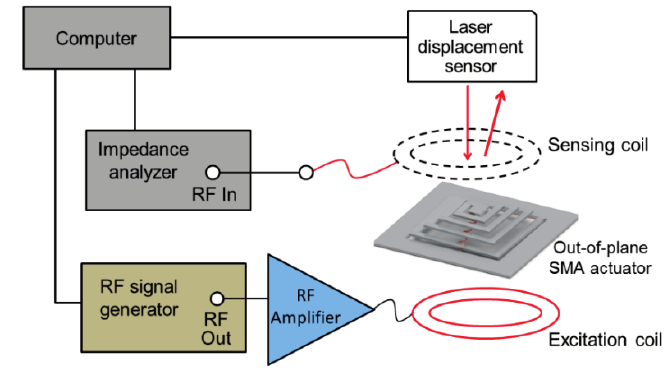
Figure 4. Wireless set-up used for device characterization and sensing tests.